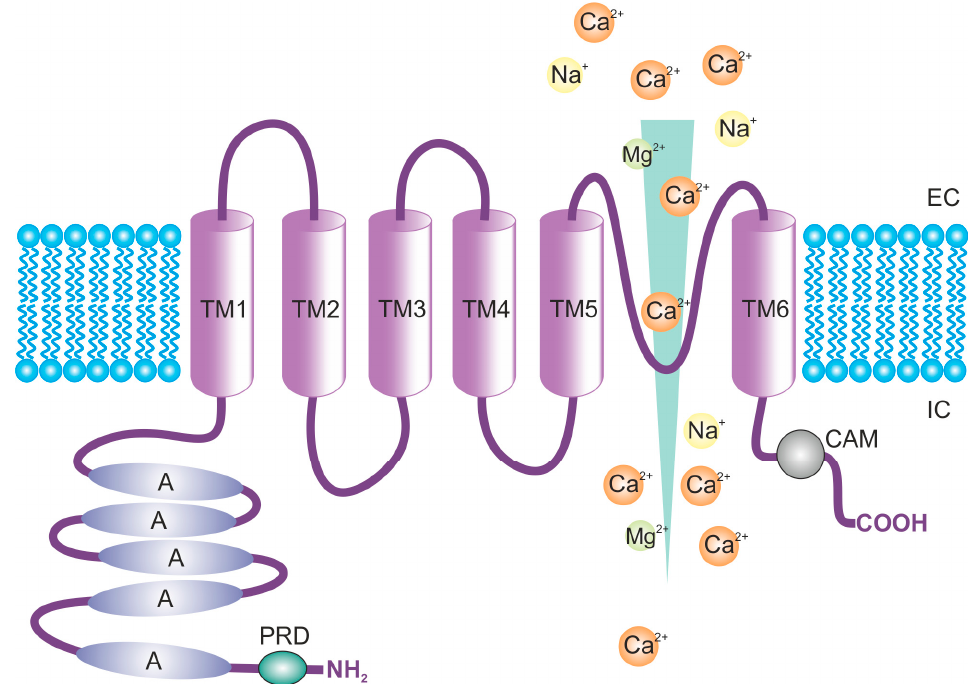
Figure 1. Structure of the transient receptor potential cation channel subfamily V member 4 (TRPV4), with the main functional domains. Abbreviations: A, ankyrin; CAM, Ca 2+ /calmodulin binding site; EC, extracellular side; IC, intracellular side; TM, transmembrane domain; PRD, proline-rich domain.